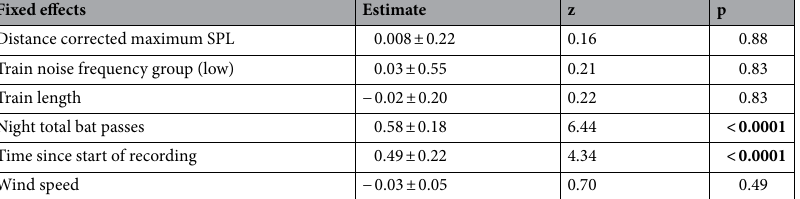
Table 2. Parameter estimates (± 95% confidence intervals), z- and p-values for fixed effects averaged across the best fitting linear models (see “Methods”) relating bat activity in the 30 s after a train pass with distance corrected maximum SPL during the train pass, train noise frequency group and train length, controlling for effects of nightly bat pass total (total bat passes recorded during inter-train gaps per 3.5 h recording period), time since start of recording, and wind